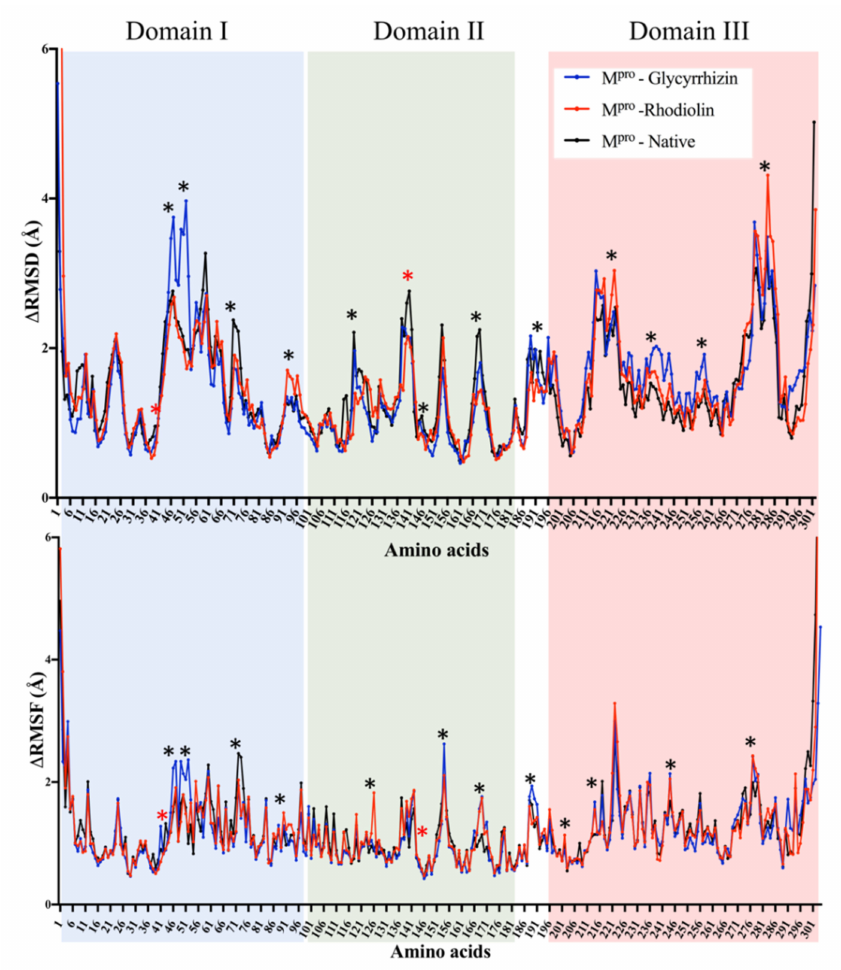
Figure 3. RMSD and RMSF calculated from 30 ns molecular dynamics simulation of Glycyrrhizin (blue) and Rhodiolin (red) docked with SARS-CoV-2 main protease (MPro) The residues with dynamic RMSD and RMSF are mentioned with ‘*’ while red ‘*’ shows the active site